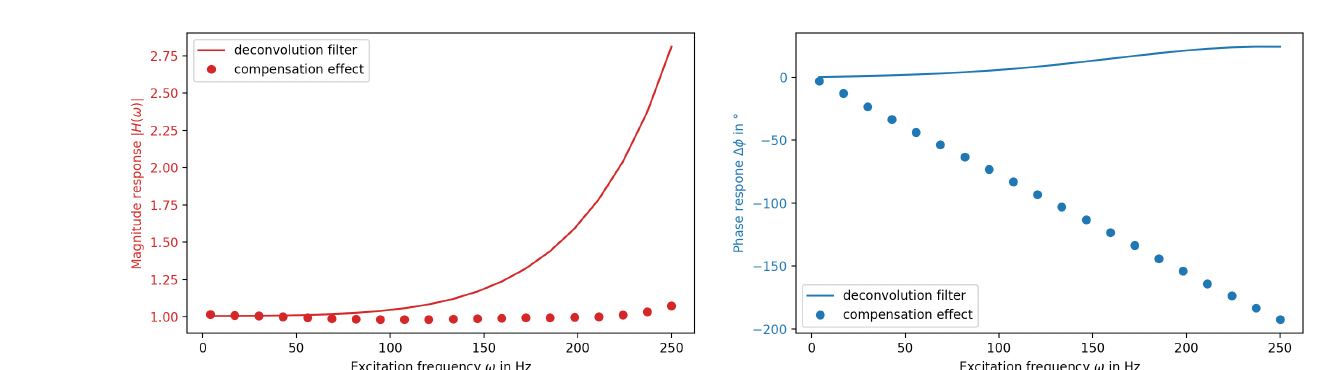
Figure 6. Example: Computed deconvolution filter and compensation behavior of the sensor presented in Figure